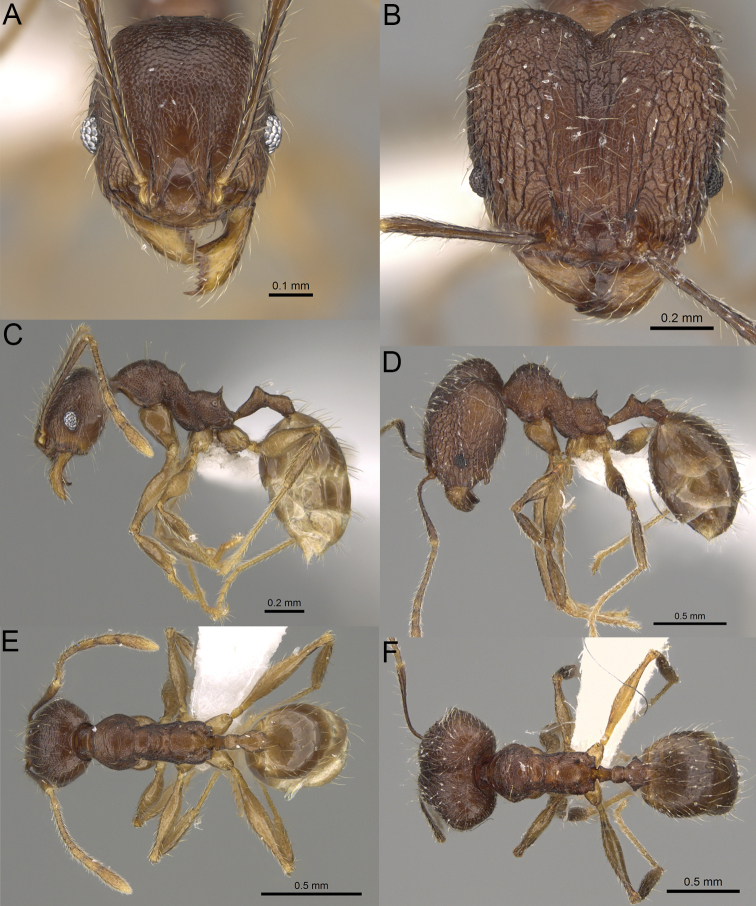
Pheidole
joffreville sp. nov., full-face view (A), profile (C), and dorsal view (E) of paratype minor worker (CASENT0406352) and full-face view (B), profile (D), and dorsal view (F) of holotype major worker (CASENT0406355).